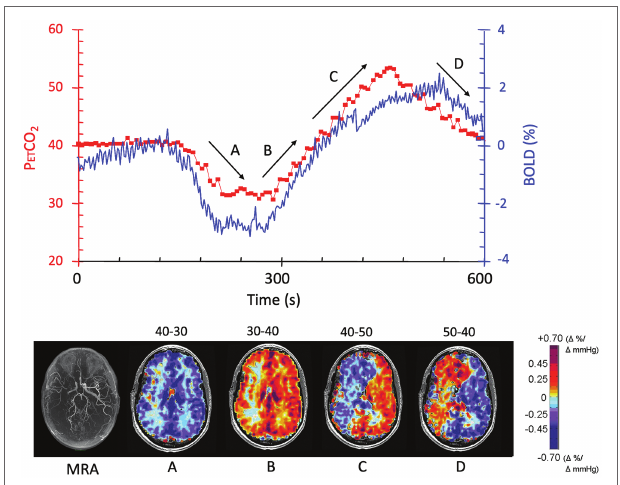
FIGURE 3 | The effect of direction of change of PaCO 2 on CVR. The patient is the same individual whose data are shown in Figures 1 , 2 . The experimental paradigm of changes in P ET CO 2 is shown in red in the graph; BOLD signal changes are shown in blue. CVR maps shown in the lower figure correspond to the periods depicted on the graph, with arrows showing the direction of change in P ET CO 2 . (A) As P ET CO 2 is reduced from 40 mmHg to 30 mmHg, there is a symmetrical reduction in BOLD signal in the white and gray matter in both hemispheres. (B) The mirror image change in P ET CO 2 from 30 mmHg to 40 mmHg results in an asymmetrical change where flow increases in the left hemisphere while decreasing in the right (steal). (C) Continuation of increase in P ET CO 2 to 50 mmHg exacerbates the flow discrepancies. (D) Reducing the P ET CO 2 from 50 mmHg to 40 mmHg reduces flow in the healthier left hemisphere as expected when P ET CO 2 falls. However, the blood vessels in right hemisphere paradoxically increase their flow, a feature attributed to the improved perfusion pressure as left hemisphere vessels constrict. Modified from Sobczyk et al. (2014).